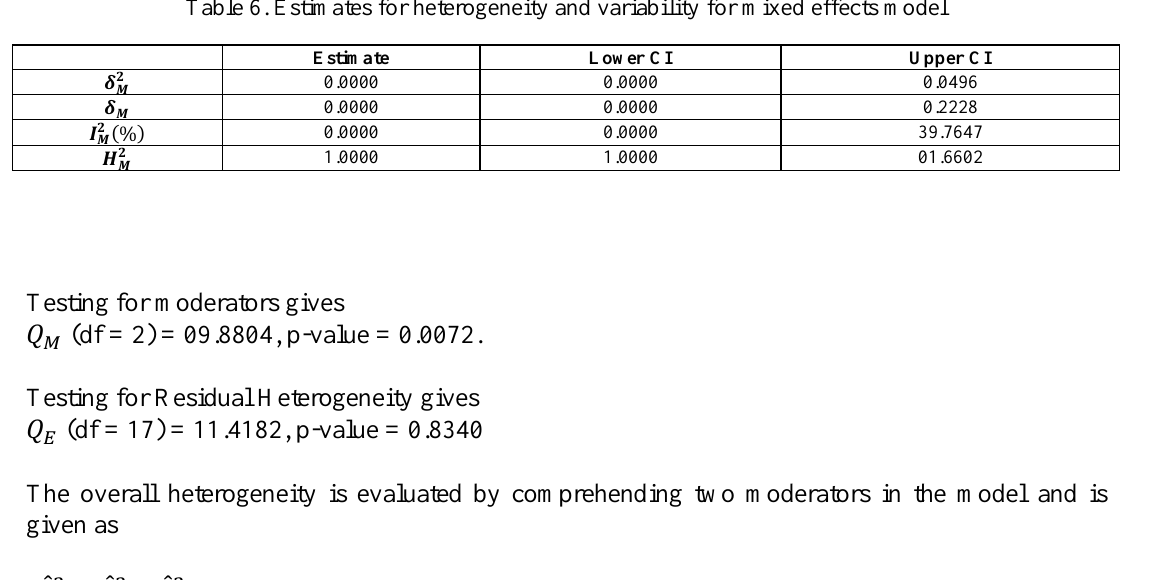
Table 6. Estimates for heterogeneity and variability for mixed effects